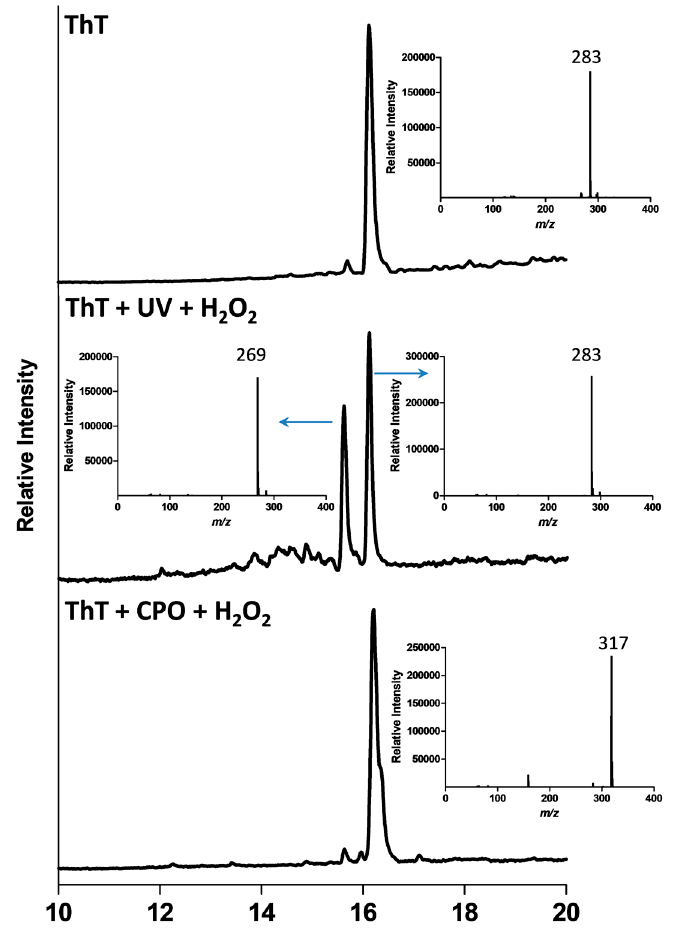
Figure 3. Liquid chromatography-mass spectroscopy (LC-MS) chromatogram and mass spectrometry-mass spectrometry (MS-MS) analyses of ThT degraded by UV + H 2 O 2 and CPO + H 2 O 2 processes. The conditions for UV + H 2 O 2 degradation were: concentration of ThT = 25 ppm, pH = 2, concentration of H 2 O 2 = 1 mM, and for CPO + H 2 O 2 degradation: concentration of ThT dye = 25 ppm, pH = 2, concentration of H 2 O 2 = 1 mM, concentration of CPO = 10 nM. Table 1. Peak area of intermediates produced during the degradation of ThT by UV + H 2 O 2 and CPO + H 2 O 2 processes.